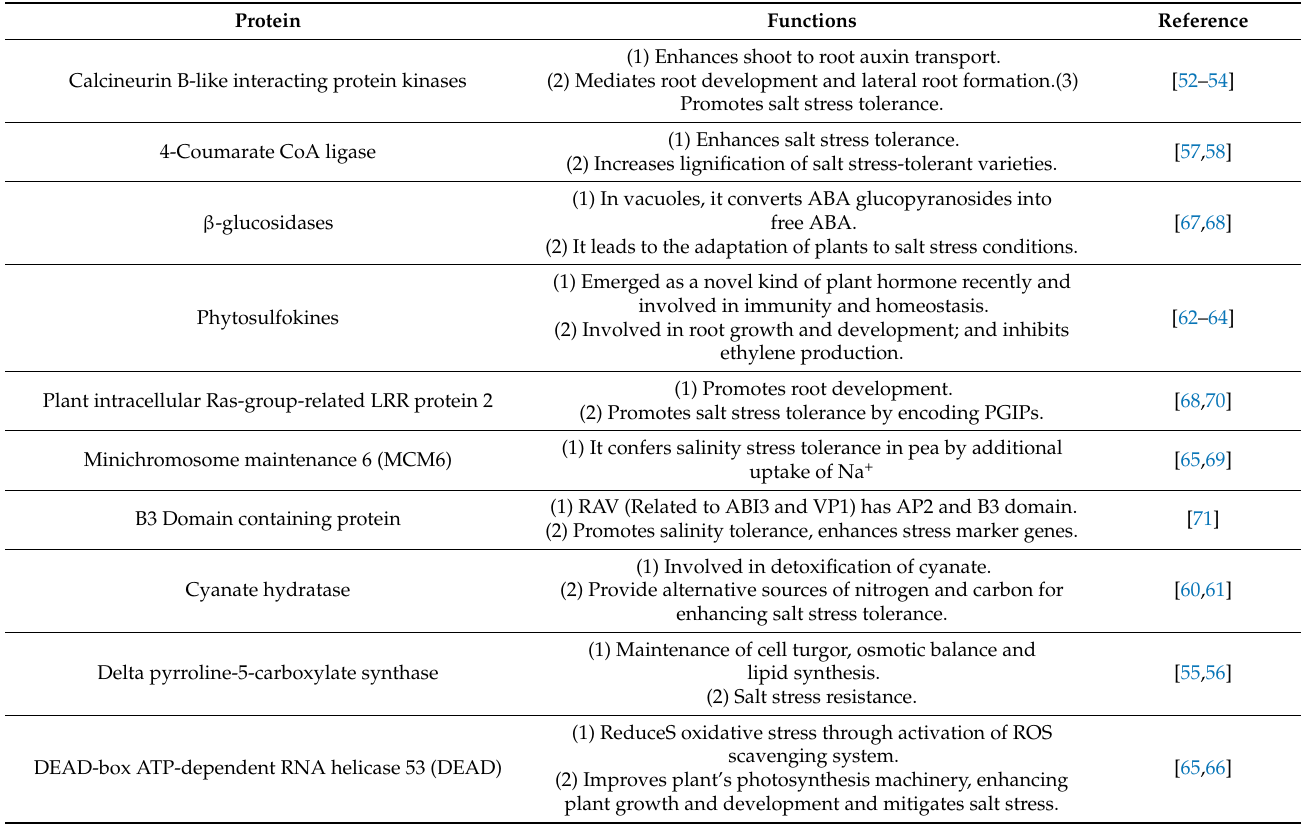
Table 3. Role of identified stress marker proteins in salinity stress tolerance. Protein